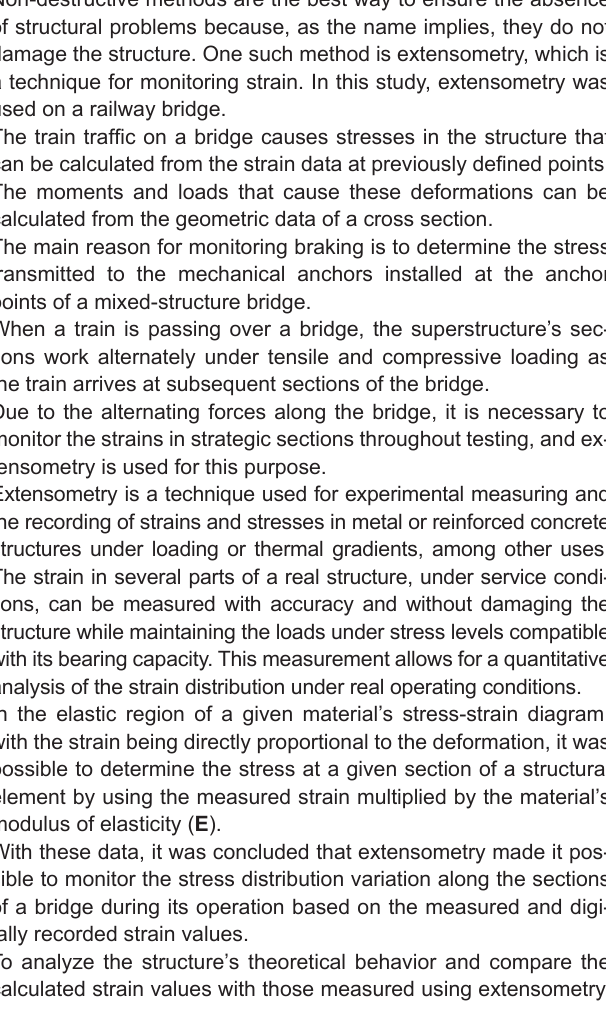
Figure 1 – Cross section of the bridge with road lanes [3]